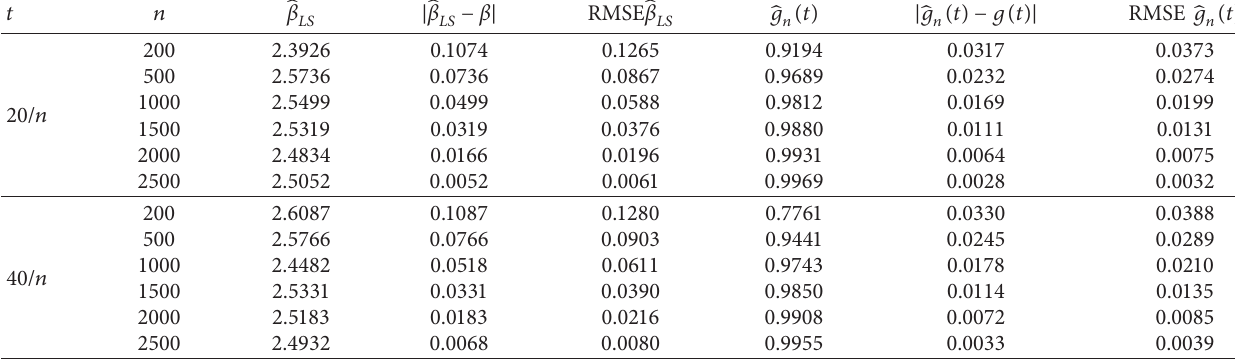
􏽢 g ( t ) with β � 2 . 5 and g ( t ) � cos ( π t ) . n LS and